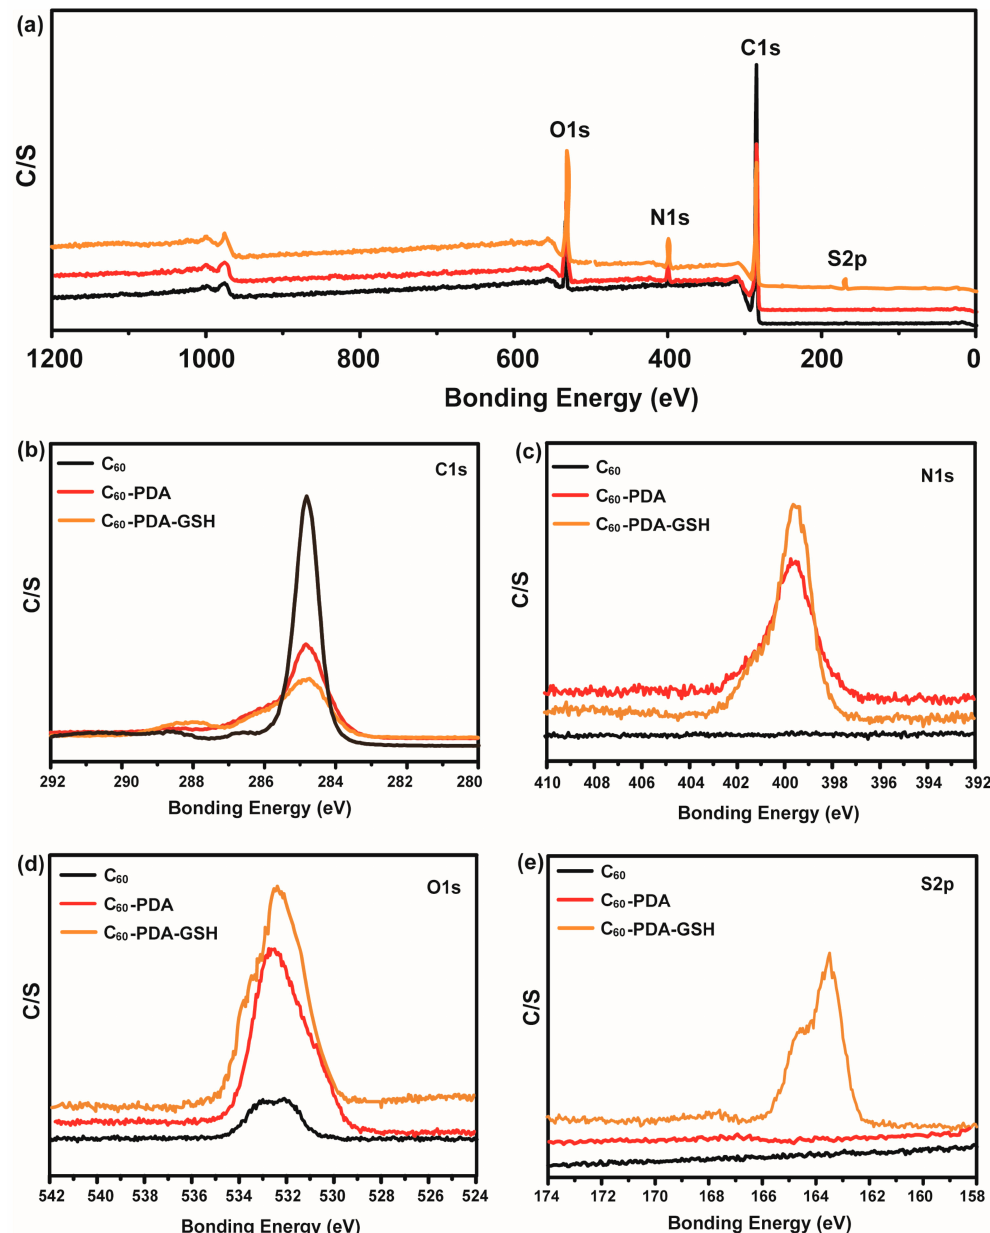
Figure 2. XPS spectra of C 60 , C 60 -PDA and C 60 -PDA-GSH ( a ) survey scan of the spectral region from 0